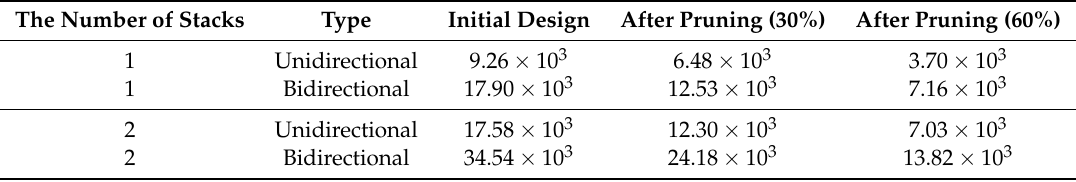
Figure 6. Operation of two-stacked bidirectional & unidirectional LSTM RNN models with pruning. Table 1. Number of